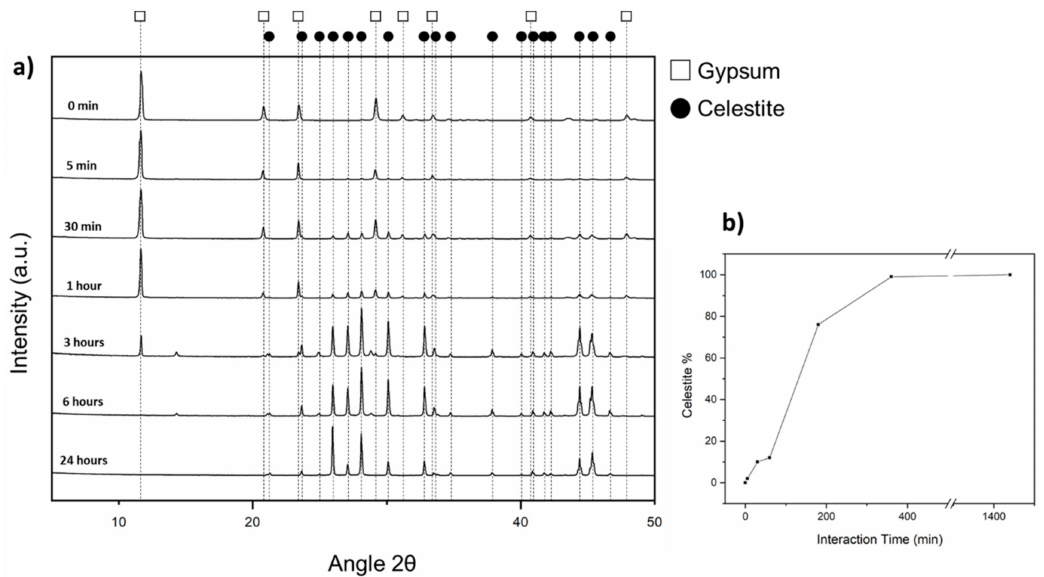
Figure 1. ( a ) X-ray di ff raction patterns of gypsum crystals after di ff erent times of interaction with a 0.5 M Sr-bearing aqueous solution. The X-ray di ff raction patterns show that gypsum grains are almost fully transformed into celestite after 6 h. After 24 h the transformation is complete. ( b ) Newly formed celestite content of the gypsum interacted samples, calculated from RIR analyses of XRD data, plotted against interaction time.